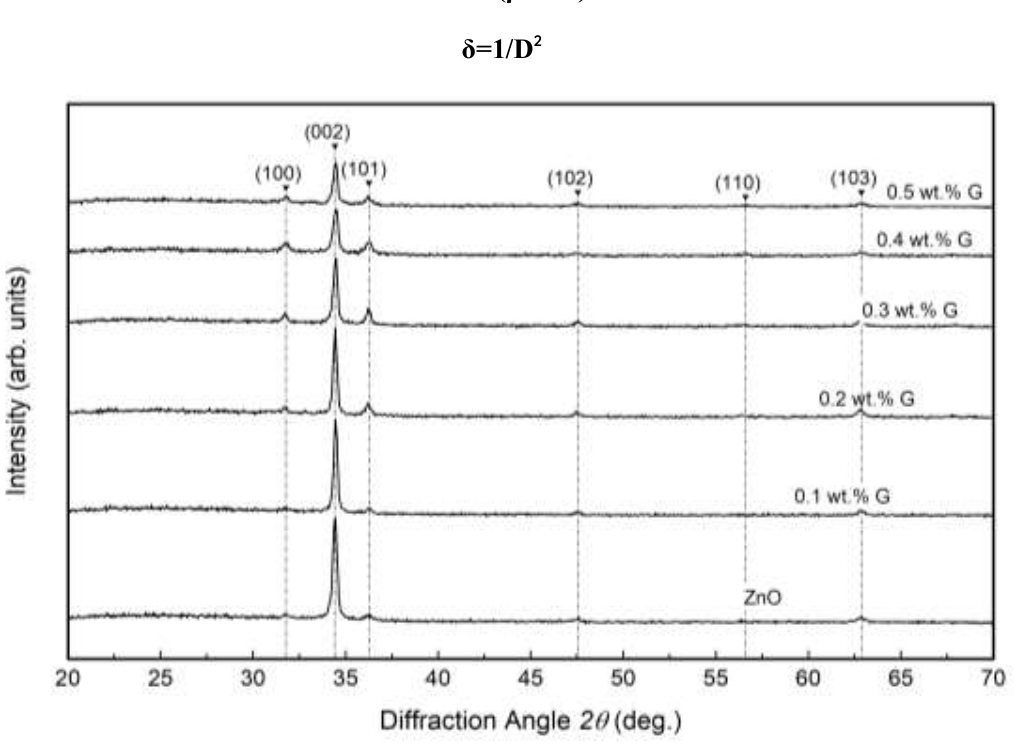
Figure 1: XRD pattern of ZnO-graphene thin films sprayed at 350 o C. Table 1 : The lattice parameters of graphene-ZnO thin films at different